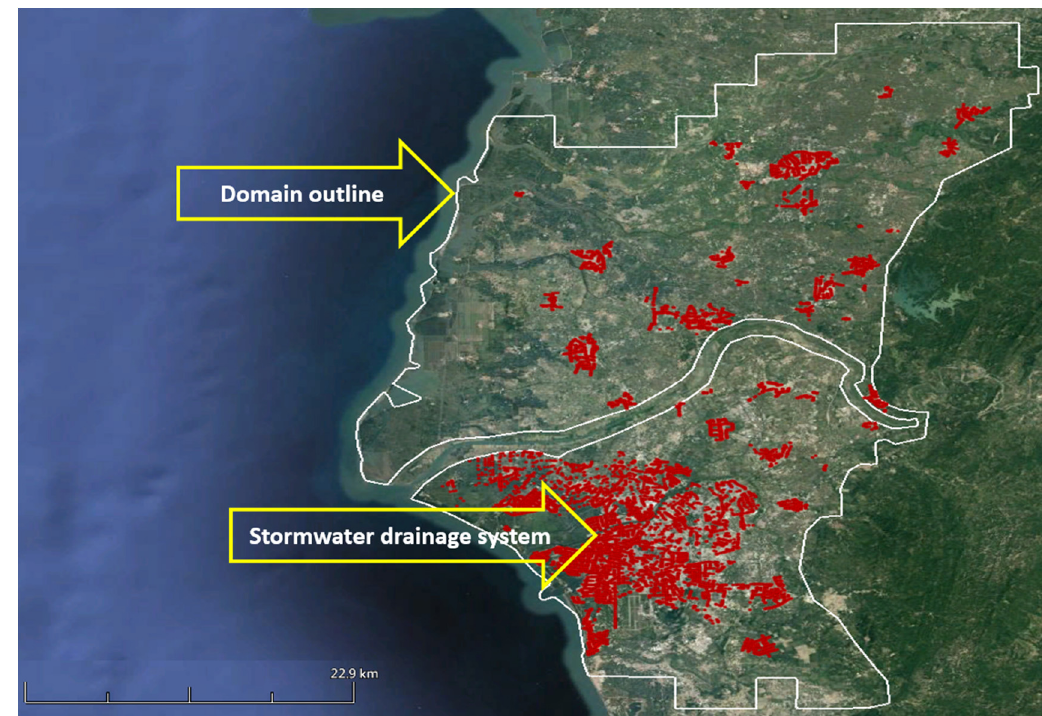
Figure 5. Outline of the computational domain (area inside the white line) and spatial distribution of the stormwater drainage system (red lines) in the computational domain.